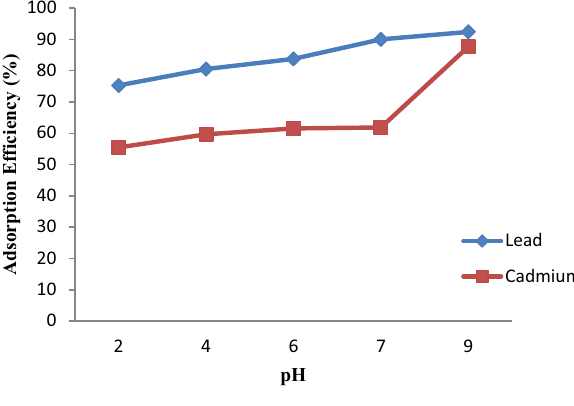
Fig. 1 Effect of pH on Pb 2+ and Cd 2+ Adsorption by Opi